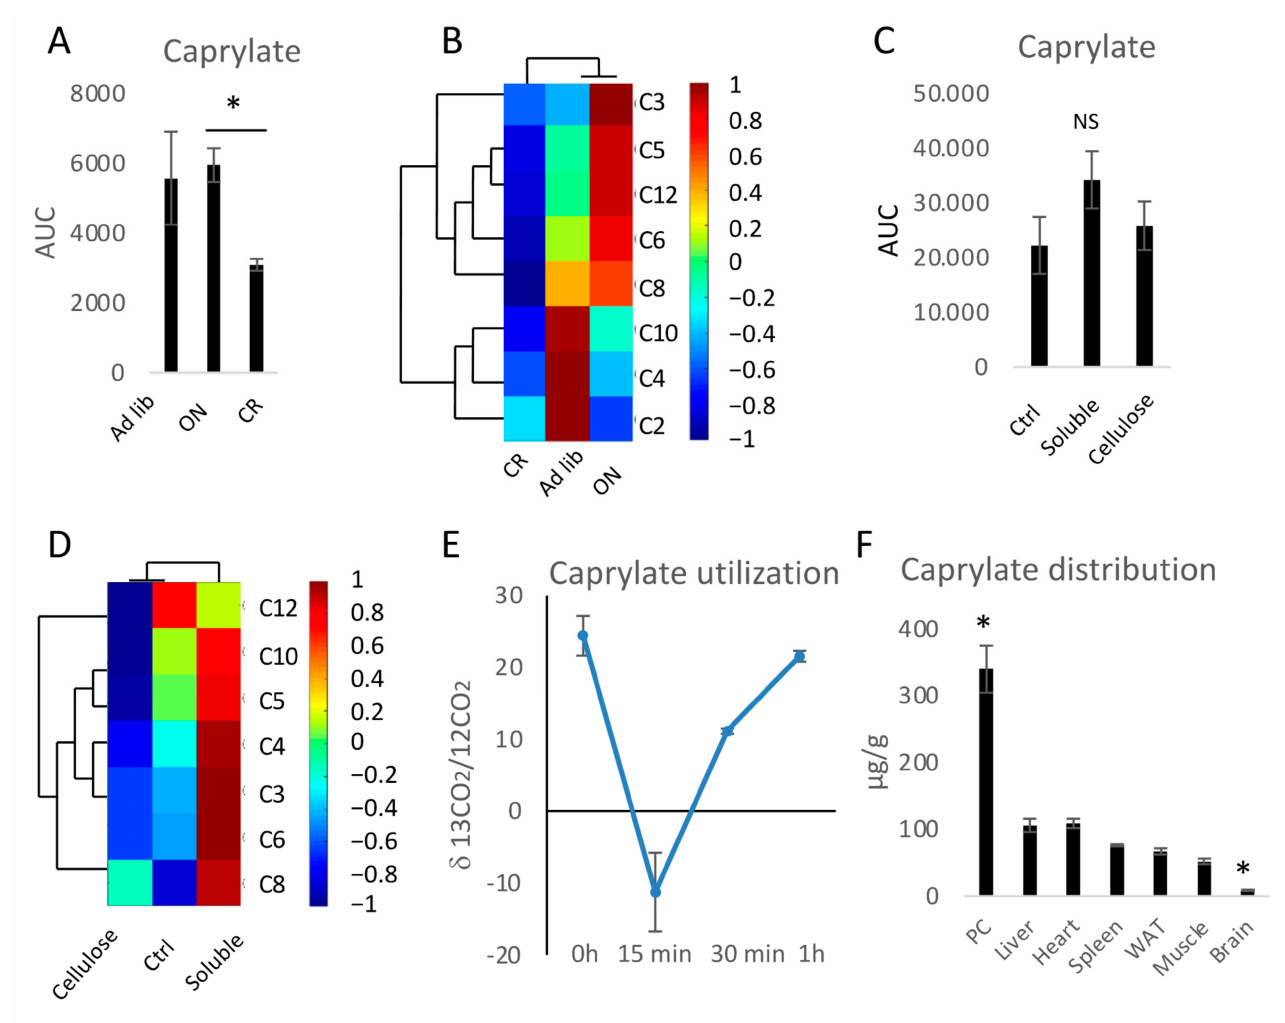
Figure 1. Medium-chain fatty acids (MCFA) found in mice cecum can be metabolized and exported to other organs. The levels of caprylate ( A ), other short-chain fatty acids (SCFA), and MCFA were measured in the cecum content of mice submitted to overnight fasting (ON) and caloric restriction (CR) ( B ). The levels of caprylate ( C ), SCFA, and MCFA ( D ) were compared between the cecum content of mice fed control (Ctrl), high soluble fibre, or high-cellulose diet. The ratio of 13 C-labelled CO 12 C CO 13 C-labelled caprylate ( E ). The 2 to 2 was measured in the breath air of mice rectally infused with levels of 13 C-labelled caprylate were measured in the proximal colon (PC), heart, liver, WAT, spleen, skeletal muscle, and the brain 1 h after rectal infusion of 13 C-labelled caprylate ( F ). Statistical significance between the experimental groups in panels ( A , C ) was evaluated using two-tailed Student’s t -tests; n = 8; * p < 0.05. In panel ( F ), * indicates p < 0.05 versus all other tissues. NS stands for not statistically significant. Data are presented as mean ± SEM. Hierarchical clustering and heatmap analysis of FAs were based on Pearson’s correlation coefficient, which is depicted as colours showing positive correlation (red) or negative correlation